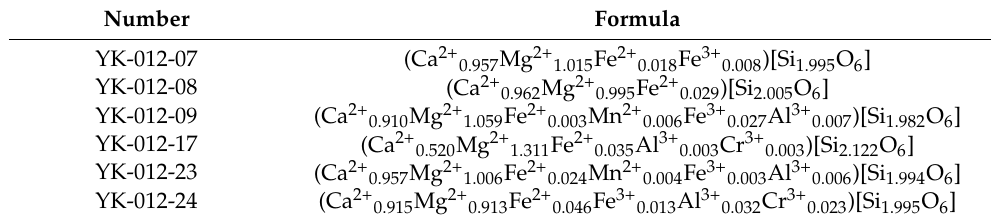
Table 2. Formulas of pyroxene in “Laoshan Jade”.